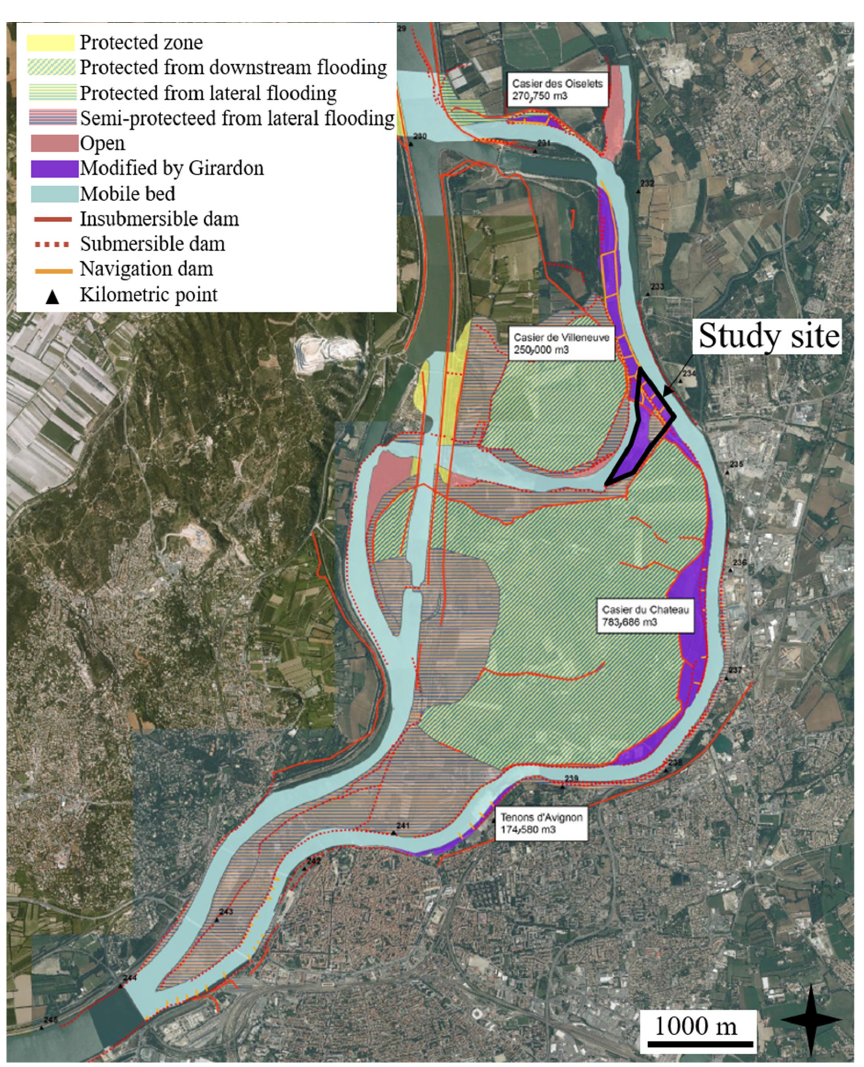
Figure 3. Hydraulic management of the Barthelasse Island ([33] modified by Poulain A.).